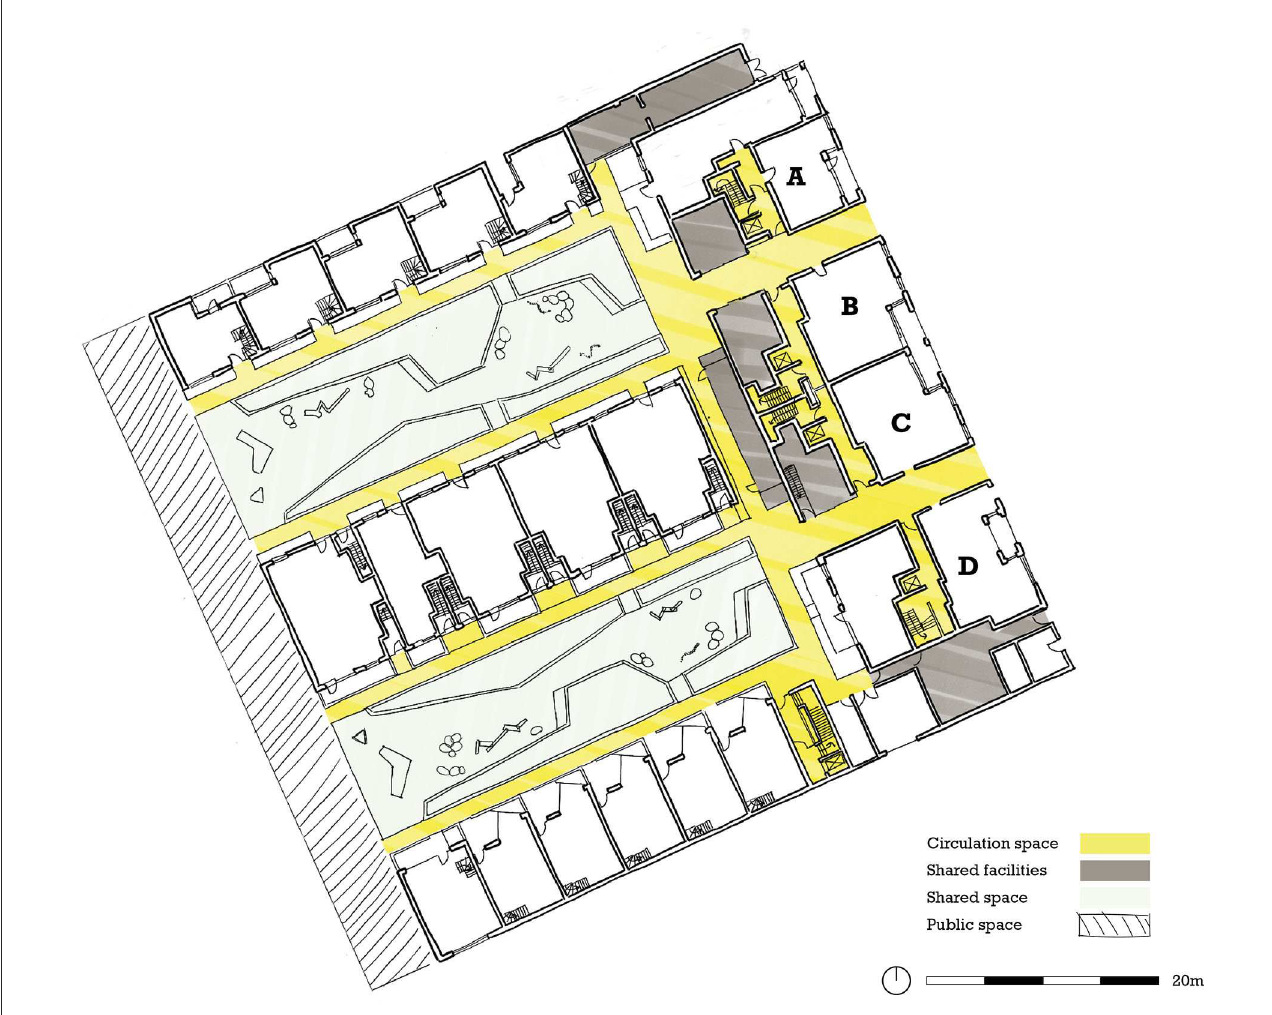
FIGURE12 Ground floor plan of Wharf